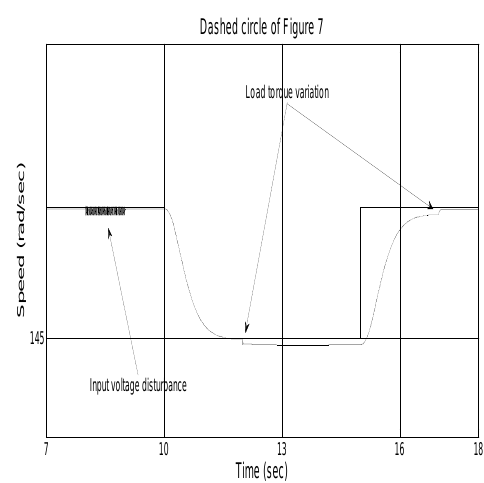
Figure 8. The tracking performance of the adaptive fuzzy MIMO method [23].